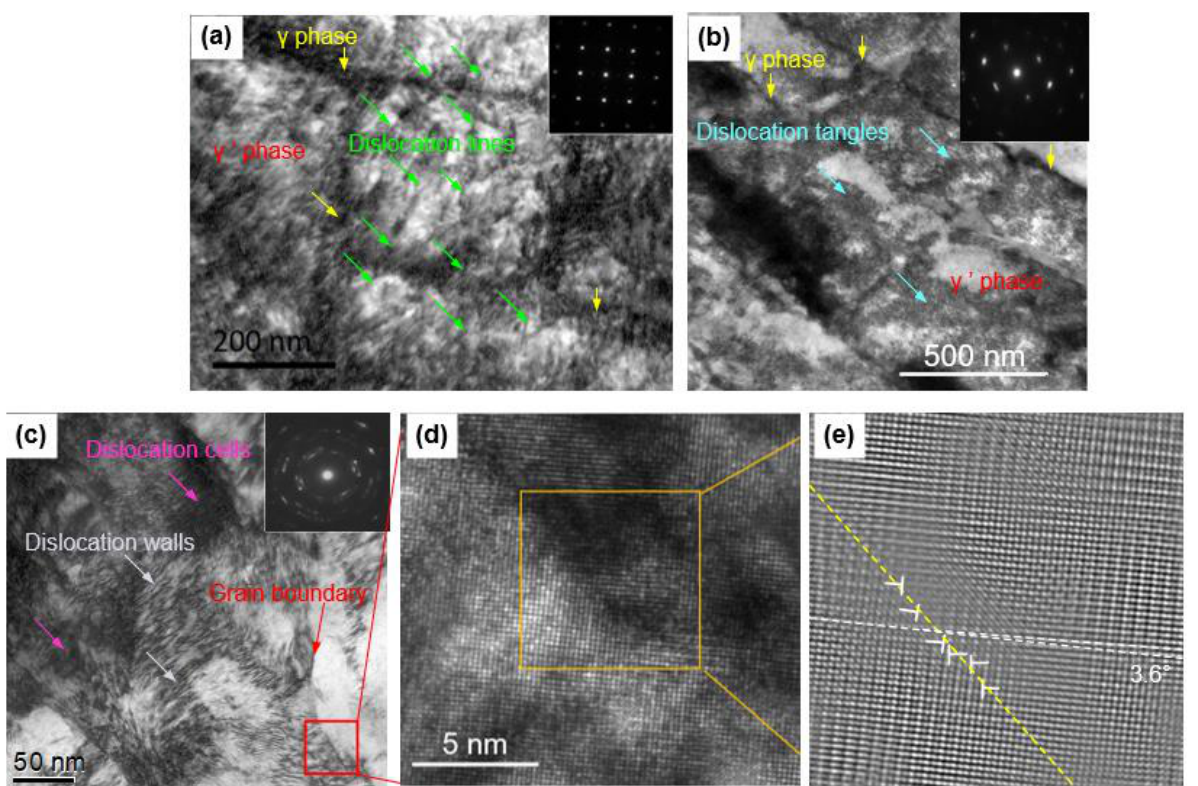
Figure 5. Typical dislocation morphology in SX alloy at different plastic deformation levels: ( a ) low; ( b ) middle; and ( c ) high; and ( d ) high-resolution TEM image of the red boxed area in ( c ). ( e ) The Fourier-filtered image corresponding to the yellow area in ( d ).